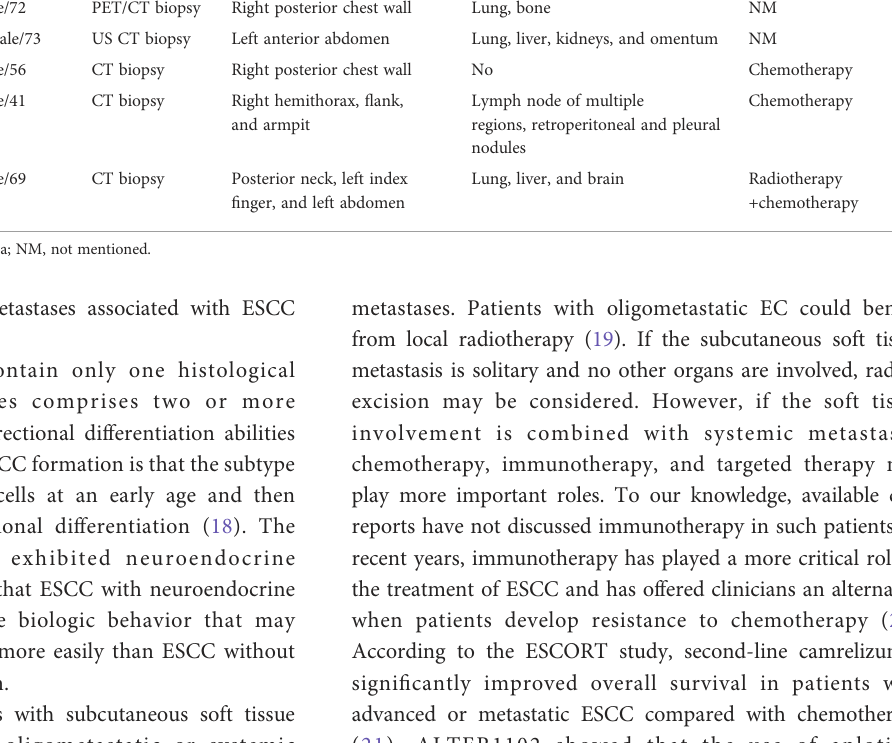
TABLE 1 Summary of previous studies reporting subcutaneous soft tissue metastases of ESCC.